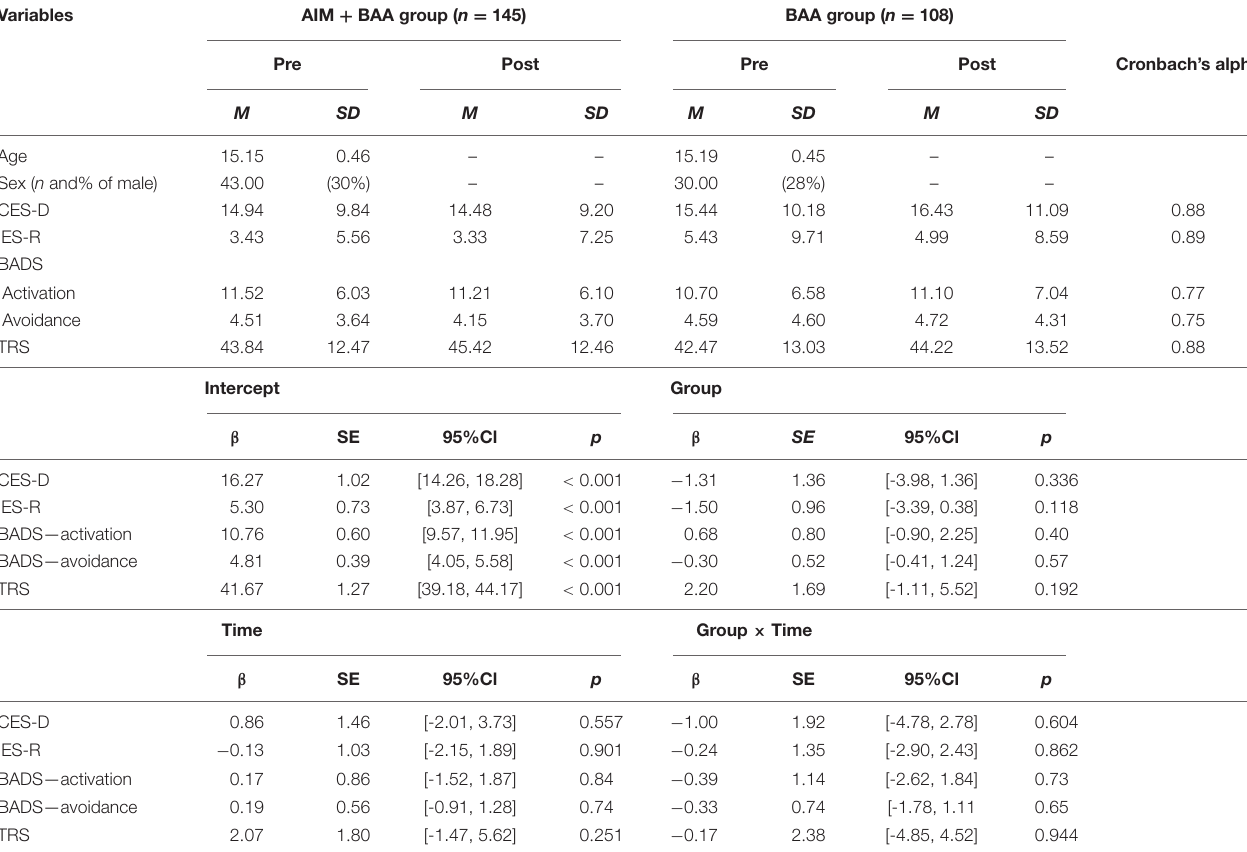
TABLE 2 | Descriptive statistics and result of Linear mixed model.